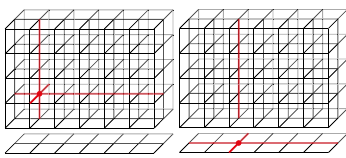
FIG. 8. Z stabilizers on the lattice described in Fig. 6. (a) Z sta- bilizer corresponding to the vertex indexed by ( i , j , k ) = ( 2, 4, 2 ) ; its support is contained in the cross of qubits highlighted as red edges in the picture. The crossing has coordinates ( z , y , x ) = ( 2, 4, 2 ) (red circle). (b) Z stabilizer corresponding to the ver- tex indexed by ( i , j , k ) = ( 3, 6, 2 ) ; its support is contained in the cross of qubits highlighted as red edges in the picture. The crossing has coordinates ( z , y , x ) = ( 3, 6, 2 ) (red circle).